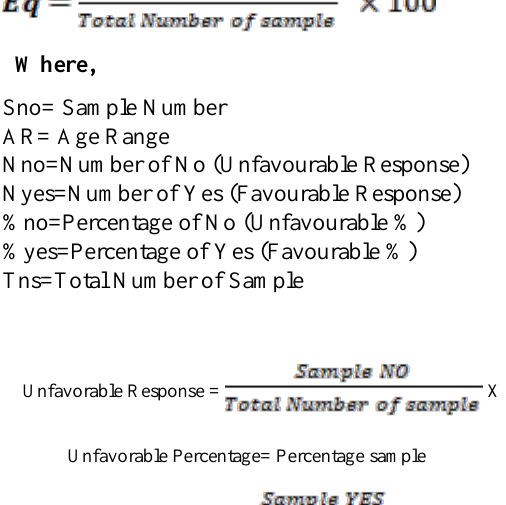
Figure 8. question one “Has IoTs change the way we think, reason, study, shop, behave and consult our health